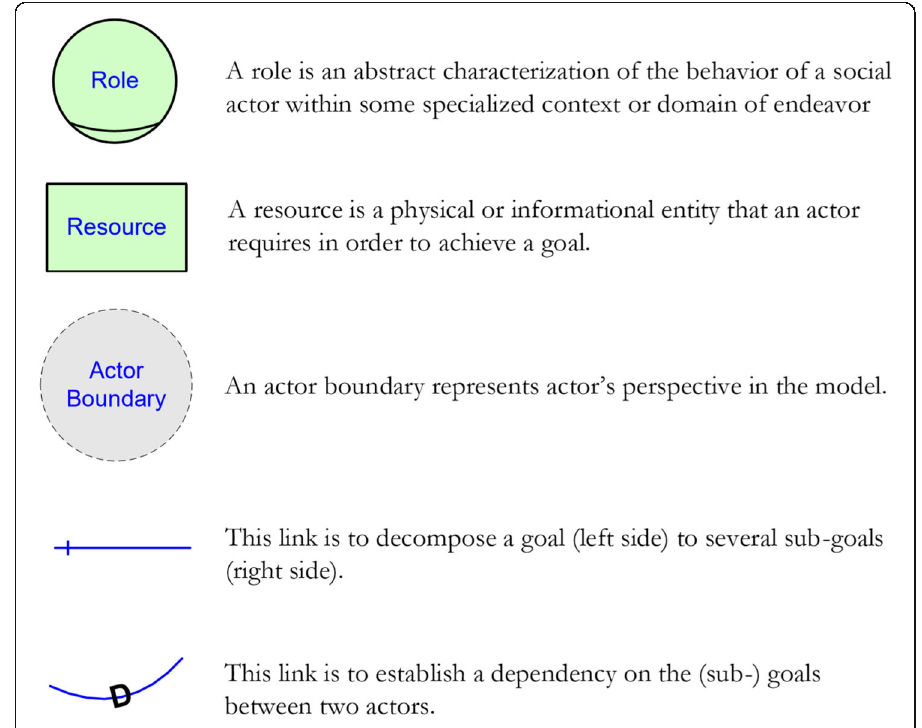
Fig. 2 Description of iStar elements used in this